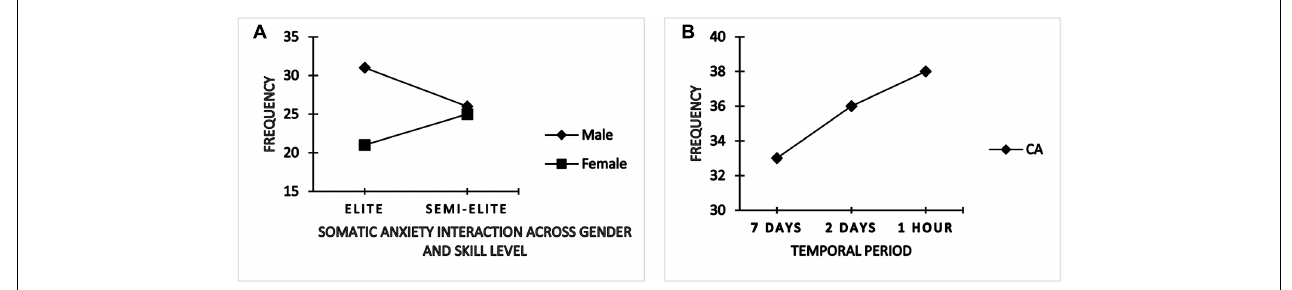
FIGURE 3 | Interaction and time-to-event changes for somatic and cognitive anxiety